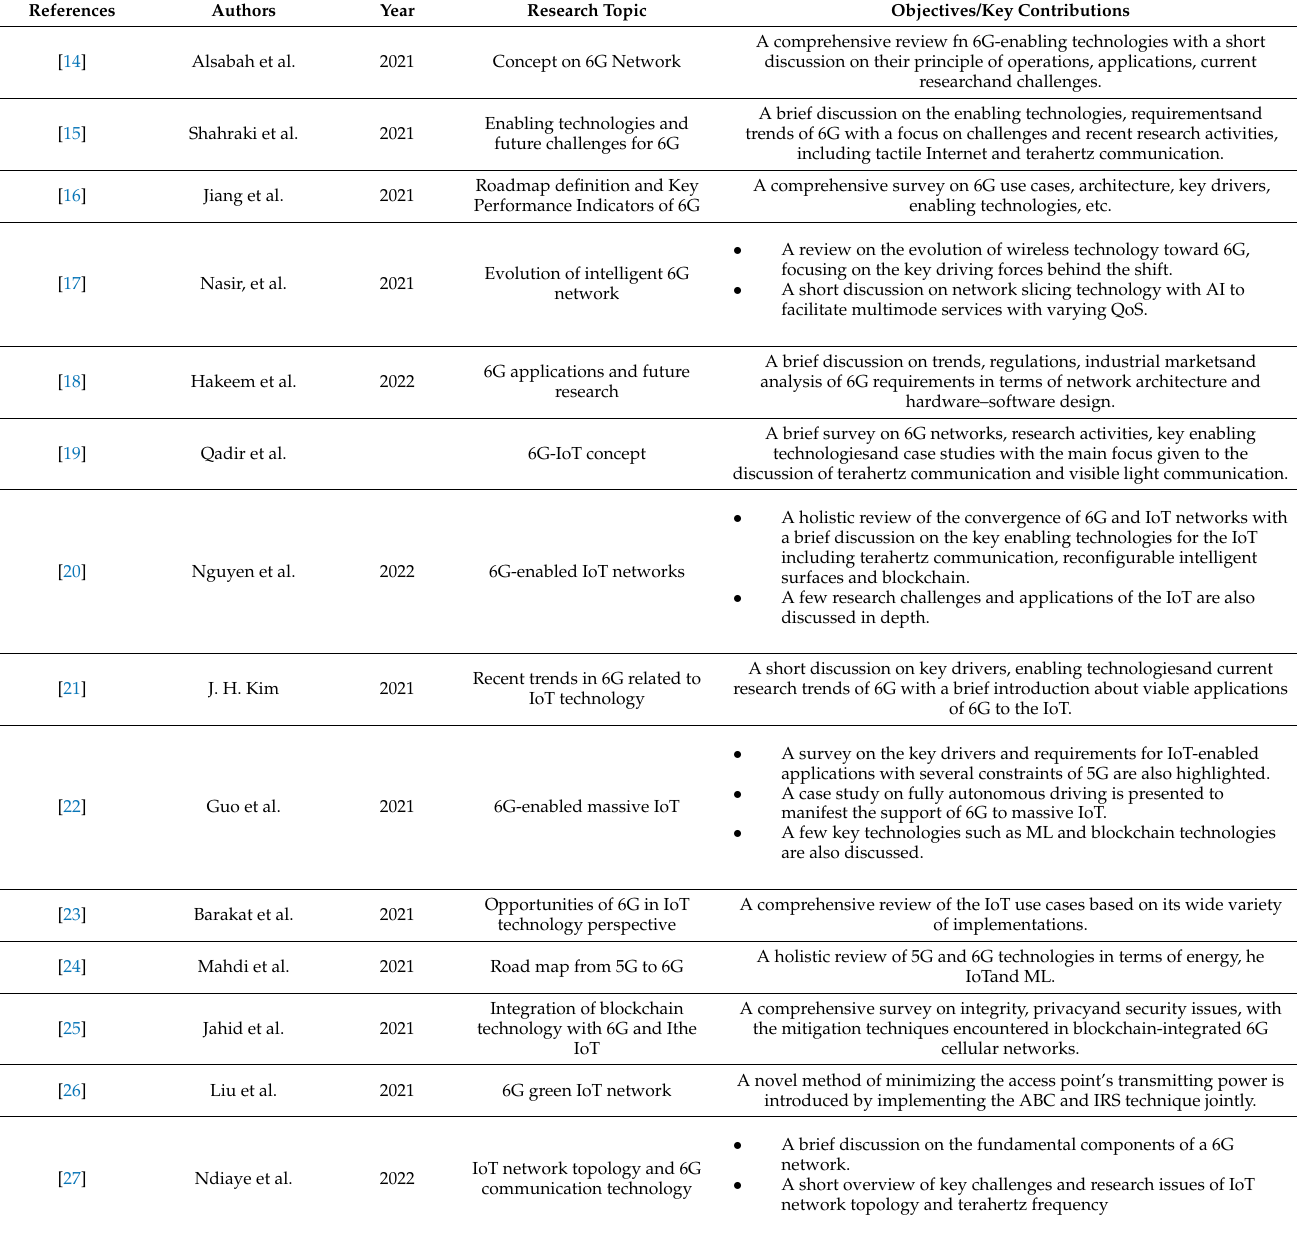
Table 1. A Comprehensive Survey of existing 6G and IoT related